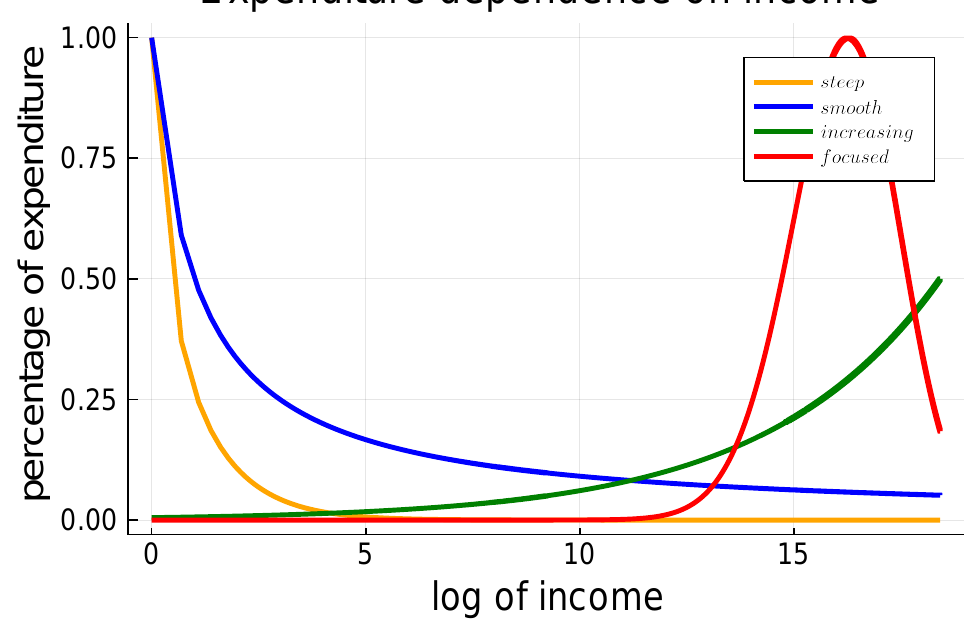
Figure 3. The blue line represents the smooth decreasing percentage according to income, the yellow line the steep decreasing percentage, the green line the steadily increasing percentage according to income and the red line upper income